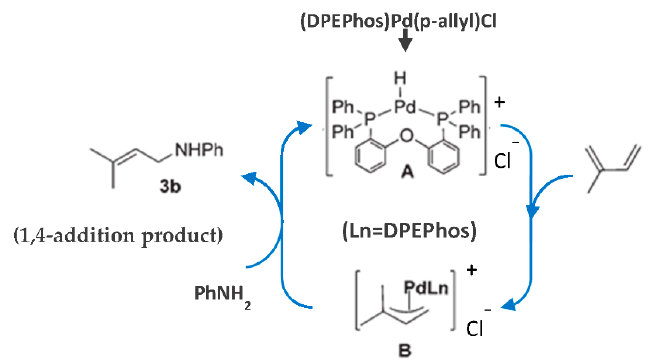
Figure 30. Proposed mechanism for the intermolecular hydroamination of 1,3-dienes with aniline. Reproduced from [89] by permission of The Royal Society of